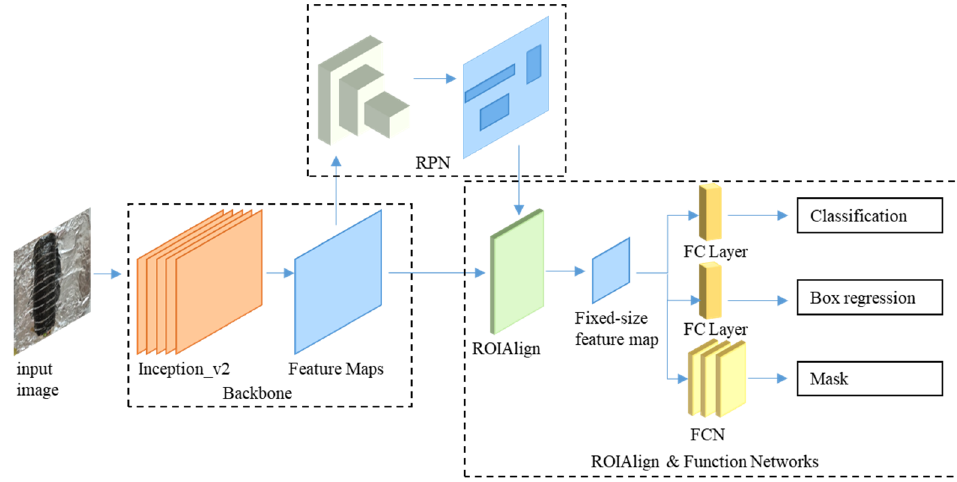
Figure 5. Architecture of Mask